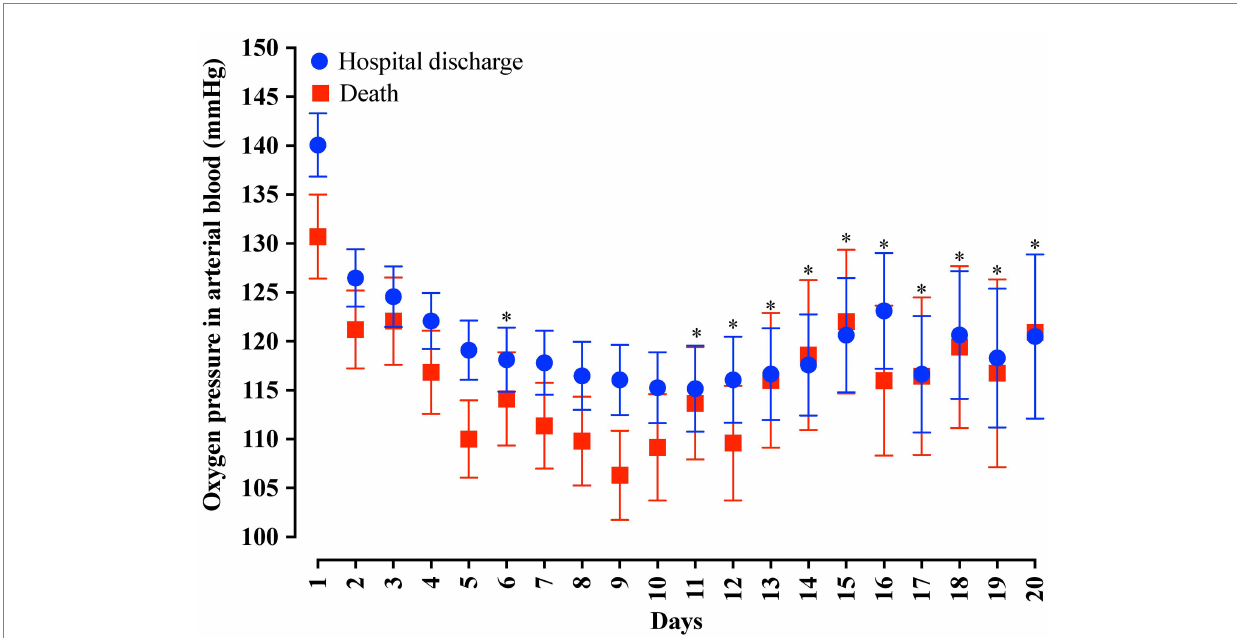
FIGURE 5 Distribution of the arterial oxygen pressure (PaO 2 ) values according to the days of invasive mechanical ventilation. Blue represents the individuals that were discharged. Red represents the individuals that died. We carried out the statistical analysis using the Mann–Whitney test and a 0.05 alpha error. The data is presented as mean [95% confidence interval, 95%CI]. * p > 0.05.